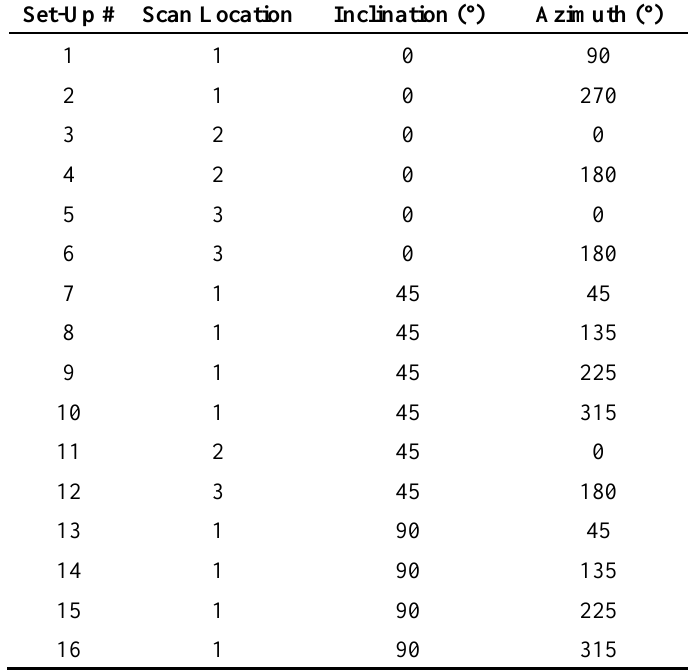
Table 1. Position and Orientation of 16 Scans in Each of the Four Datasets. Set-Up